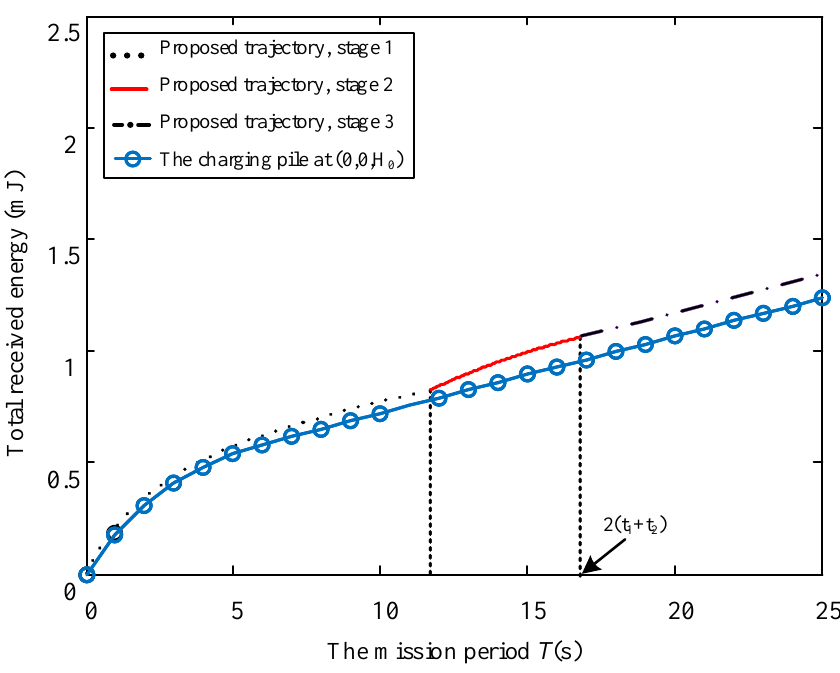
Figure 8. The relationship between total received energy and mission period T with V = 0.6.